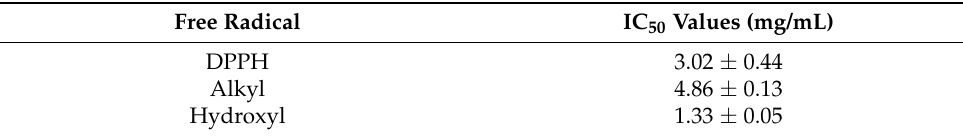
Table 1. The free radical scavenging effect of